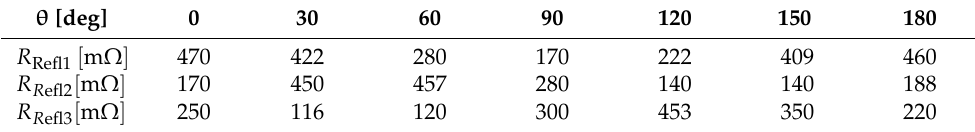
Table 7. Measurement result of reflection resistance of TX coil according to RX coil angle.